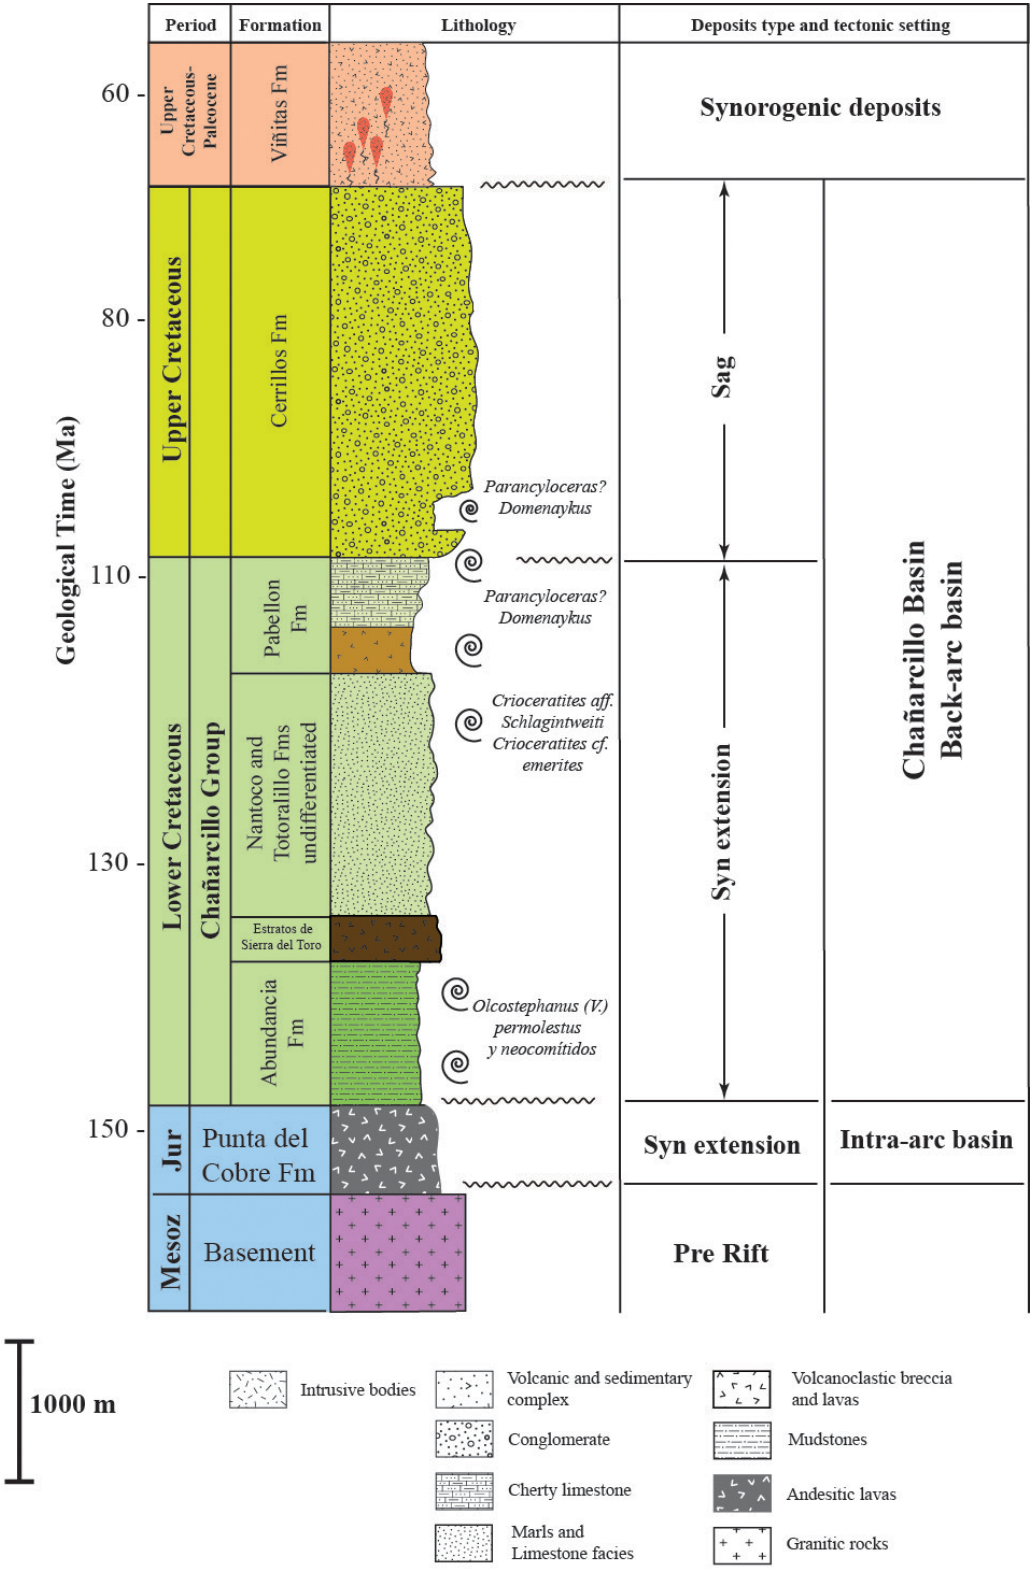
Figure 4. Simplified stratigraphic column of the Chañarcillo Basin (modified from Mourgues, 2004).